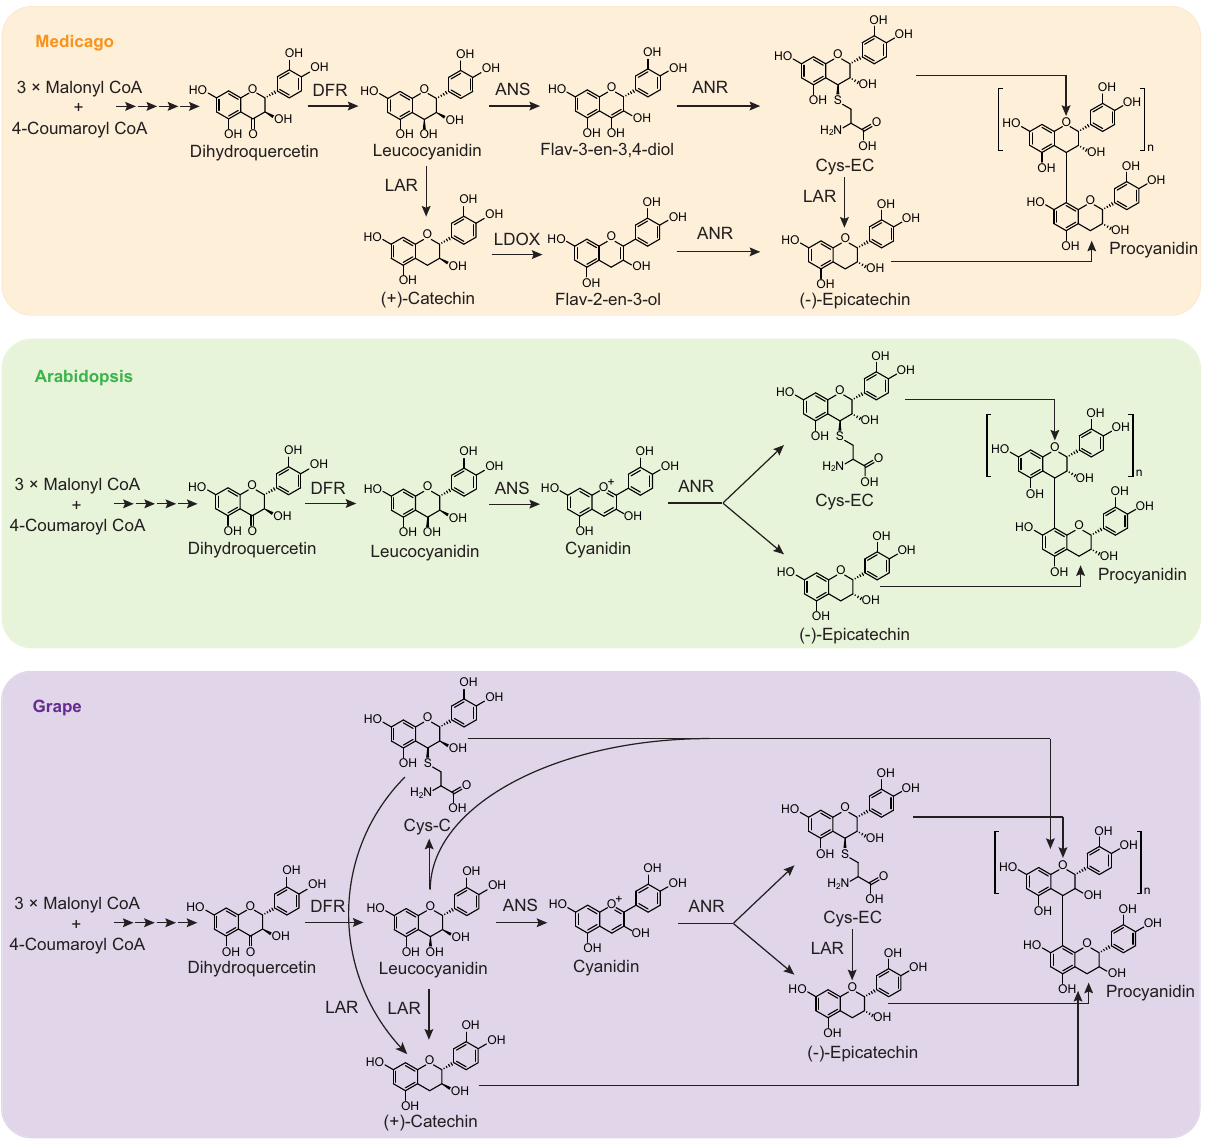
Fig. 1 Alternative pathways to PA starter and extension units. ( − )-Epicatechin-type PA starter and extension unit biosynthesis pathways in Medicago ( M. truncatula ) occur through separate by ANS-ANR and LAR-LDOX-ANR branches 6,15,16 , while ( − )-epicatechin-type PA starter and extension unit biosynthesis in Arabidopsis ( A. thaliana ) and grape ( V. vinifera ) are all derived from the ANS-ANR pathway 11,13,14 . In grape, ( + )-catechin-type PA starter unit is synthesized by LAR and ( + )-catechin-type PA extension units are derived from leucocyanidin 11 . DFR, dihydro fl avonol reductase; ANS, anthocyanidin synthase; LDOX, leucoanthocyanidin dioxygenase; LAR, leucoanthocyanidin reductase; ANR, anthocyanidin reductase. CoA, coenzyme A; Cys-C, 4 β -( S - cysteinyl)-( + )-catechin; Cys-EC, 4 β -( S -cysteinyl)-( − )-epicatechin.